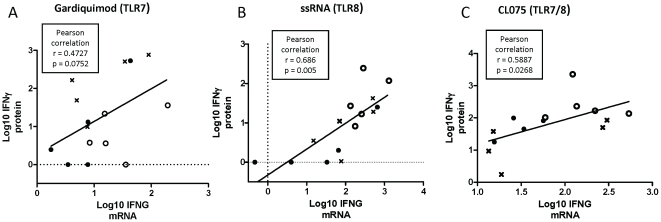
Correlations between ssRNA-induced cytokine mRNA and protein
expression.300 µl of whole blood was cultured for 4 hours with (A)
Gardiquimod™ (TLR7), (B) ssRNA (TLR8) and (C) CL075 (TLR7/8). RNA
was purified and cytokine mRNA was quantified by real time PCR as
described in Materials and Methods.
Comparisons between IFNγ protein and IFNG mRNA
levels were calculated where stimulated values (Ct and cytokine
concentrations) were divided by unstimulated values. The values were log
transformed and compared using Pearson correlation test, linear
regression line presented in graph, n =  5. At
birth (black circles), 1 month (open circles), or 12 months (crosses) of
age.